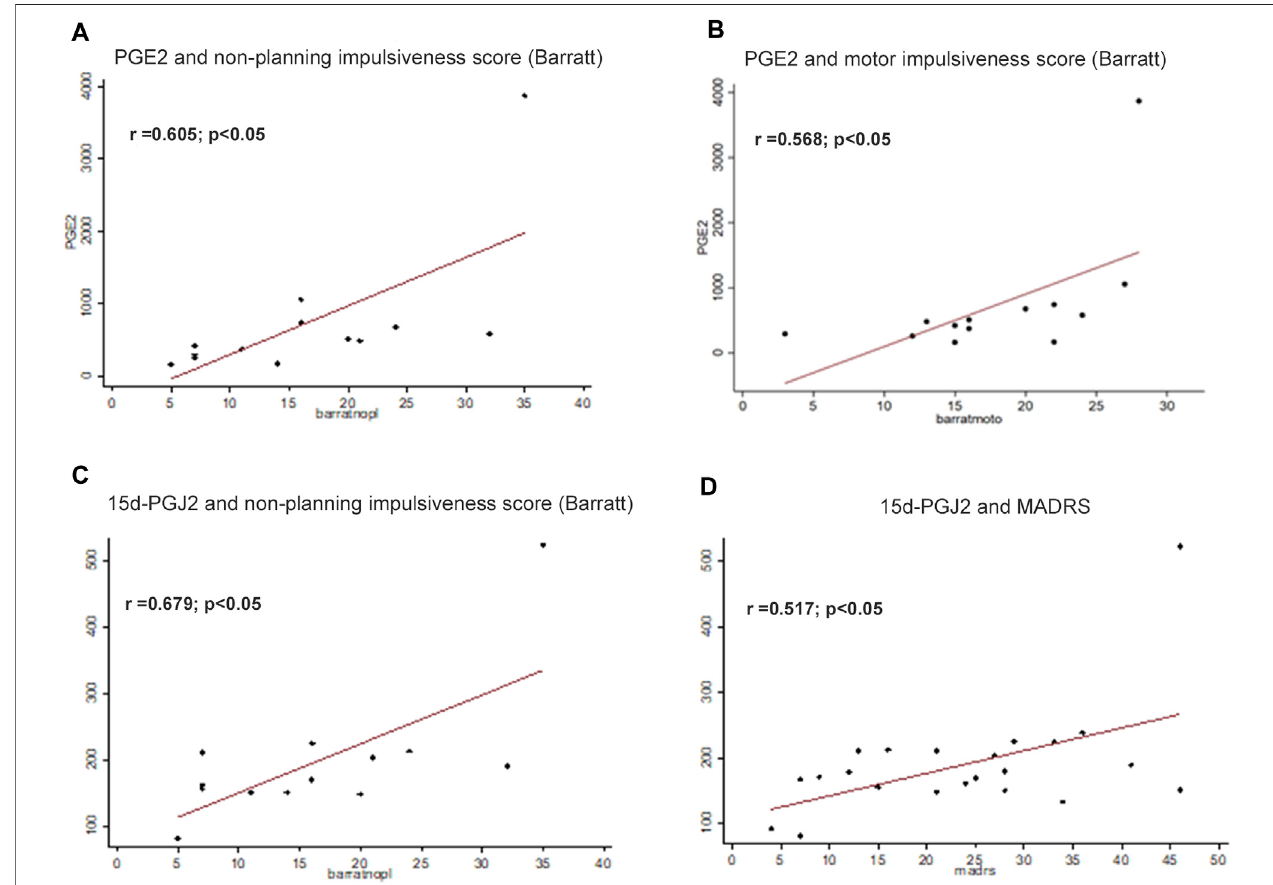
FIGURE 2 | Assessment of correlations among biological parameters and psychological tests. Plasma levels of the in fl ammatory prostaglandin PGE 2 were correlatedwithnon-planningimpulsivenessscore (A) ,andwithmotorimpulsivenessscore( r =0.568; p < 0.05) (B) .Levelsoftheanti-in fl ammatory15d-PGJ 2 correlated with Barratt questionnaire non-planning impulsiveness score (C) and Montgomery-Asberg Depression Rating Scale (MADRS) score ( r = 0.517; p < 0.05) (D) . Correlations were assessed by using Pearson correlation coef fi cient. The signi fi cance was considered p < 0.05.